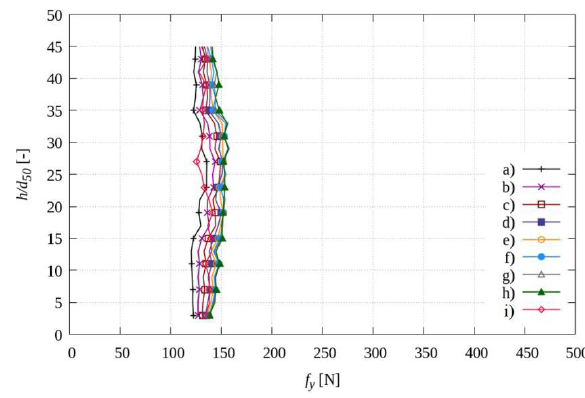
Figure 28: Distribution of the maximal normal forces f on spheres, in the averaging cell, across the normalized specimen height h / d at the specimen centre for: a) u 50 mm, c) u = 0.75 mm, d) u = 1.00 mm, e) u x x mm, g) u = 1.75 mm, h) u = 2.00 mm and i) u x x 0.60, σ = 200 kPa, d = 0.5 mm) (dark vertical line demonstrates 0 50 5% limit).